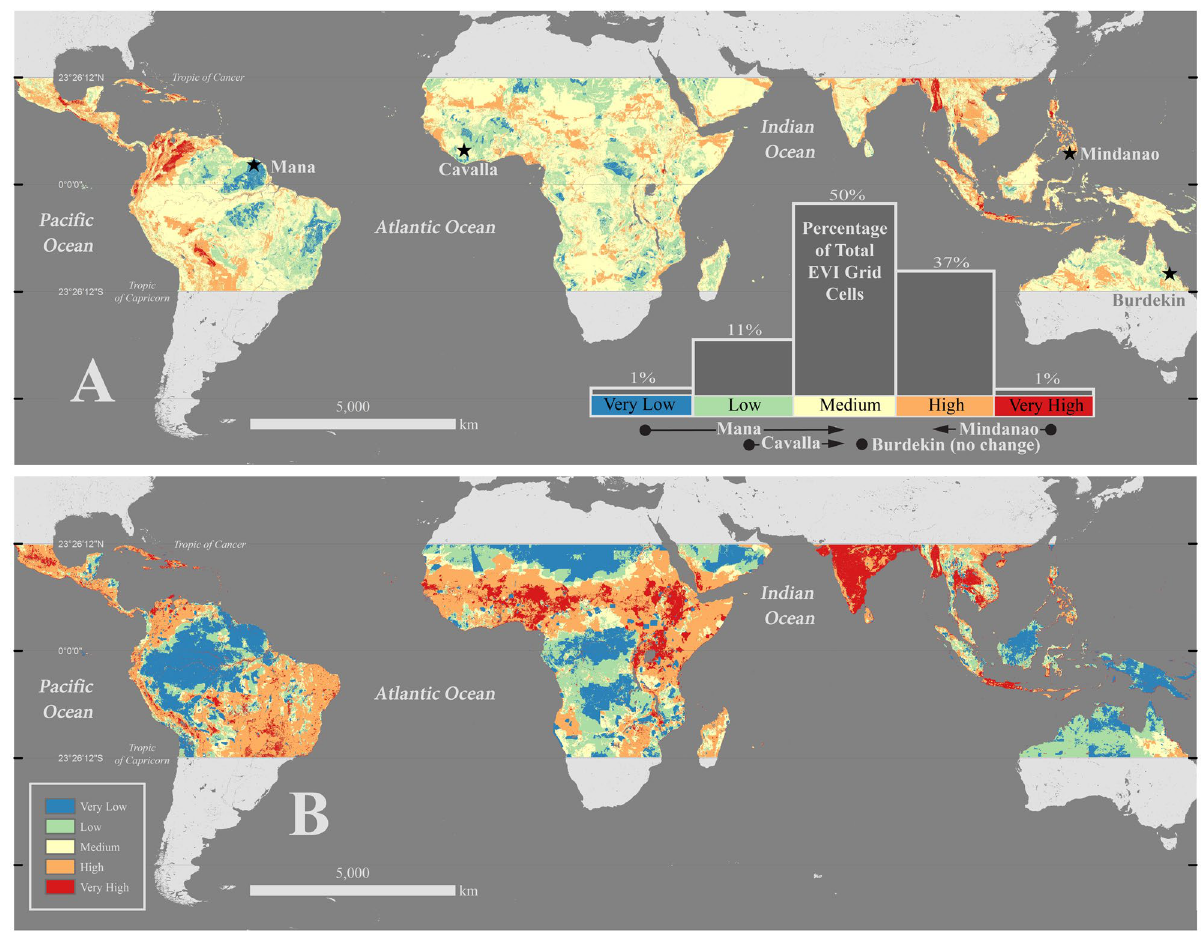
distribution of EVI and locations of 4 case studies investigated. High Risk Categories occur throughout most of Southeast Asia, along the northern Andes, in the Caribbean and through most of Central America. Low Risk Categories occur in the lower Amazon watershed and South Brazil with Low and Very Low Risk Categories throughout Africa. Histogram plot shows the entire EVI distribution over the tropics. Below the histogram plot are the names of the watersheds investigated as case studies, arrows represent how the vulnerability changed from EVI to EDVI. B The Risk Factor distribution for the Agriculture, Grazing, Mining, and Development (AGMD) variable. Note the relative lack of development throughout the tropics isolated primarily to the following regions: central and eastern Australia, central Africa, New Guinea, Borneo, and the Amazon River watershed. With impending development in the tropics this indicates that erosion issues could worsen if these undeveloped areas become developed. India is shown here almost completely covered by Very High Risk